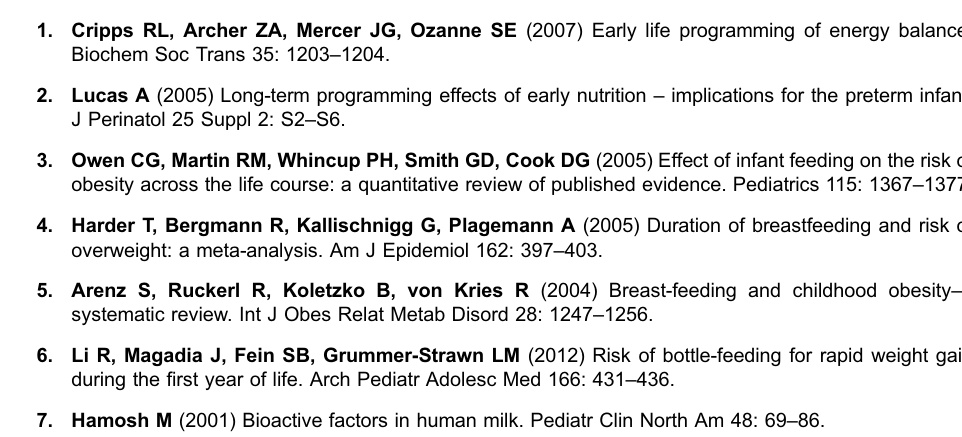
S1 Table. PRISMA 2009 Checklist, completed to assist in the proper reporting of this systematic